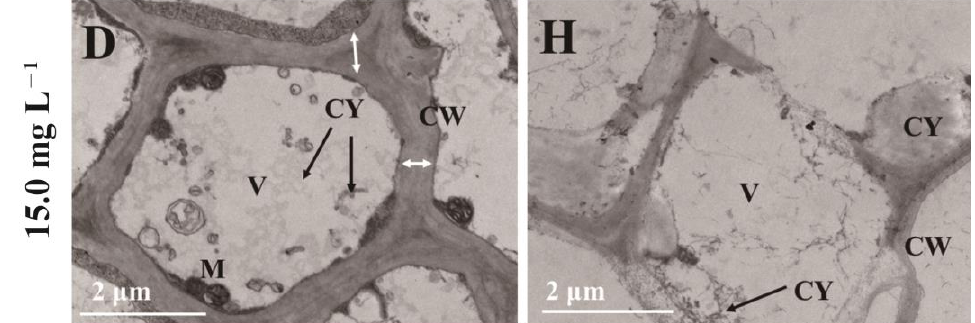
Table 2. Pearson correlation coefficients between root biomass, length, As concentration and H 2 O 2 , O 2 − , protein, MDA, GSH contents in the root, and root activity. Figure 4. Transmission electron microscopy images of the ultrastructure of root tip cells under dif-